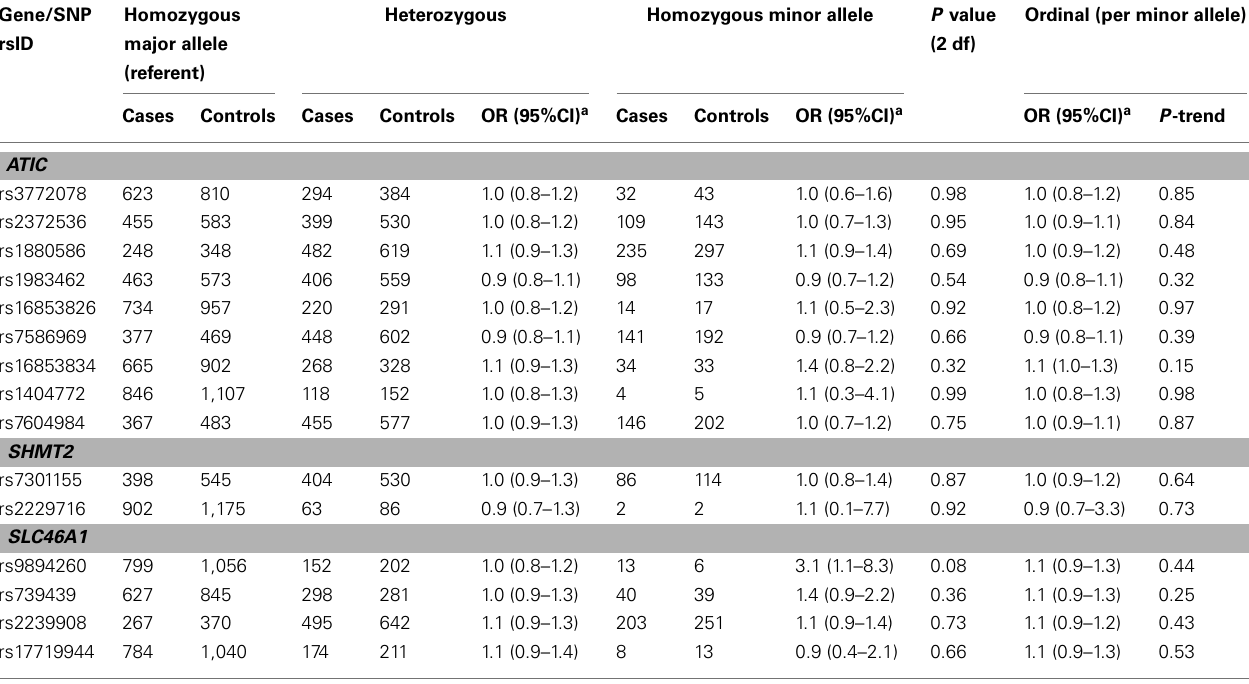
TableA5 | Odds ratios (OR) and 95% CIs for the main effect association between variants in ATIC , SHMT2 , and SLC46A1 and ovarian carcinoma among 2,233 Caucasian subjects (Phases 1 and 2), Mayo Clinic, and Duke